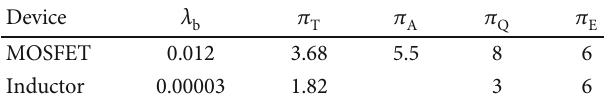
Table 5: L fi lter adjustment factors.